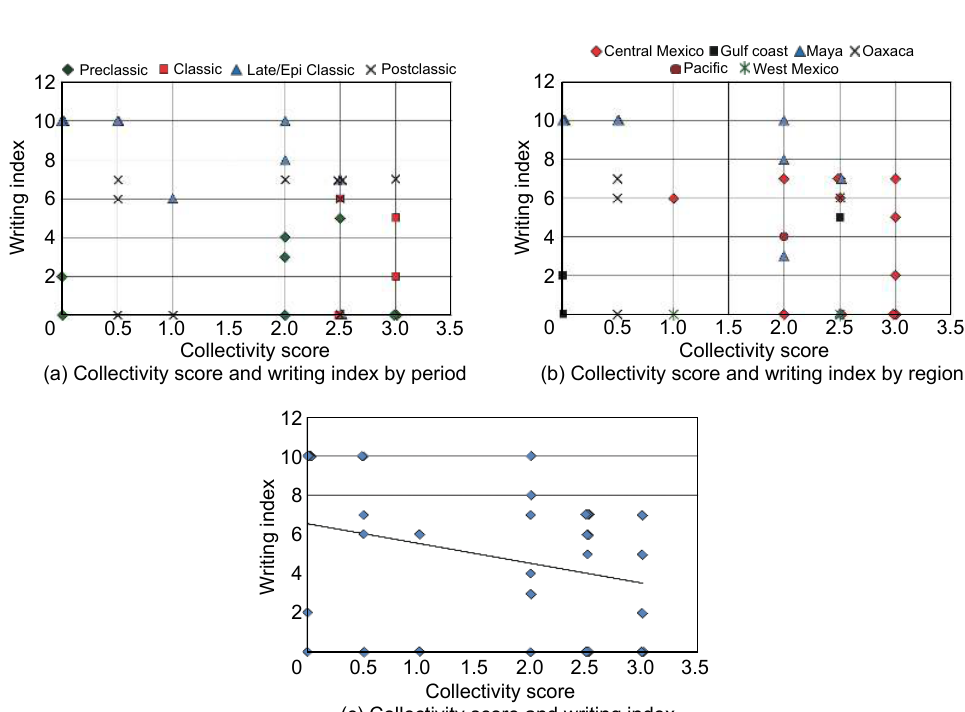
Fig. 8 Population, polity size, and governance.